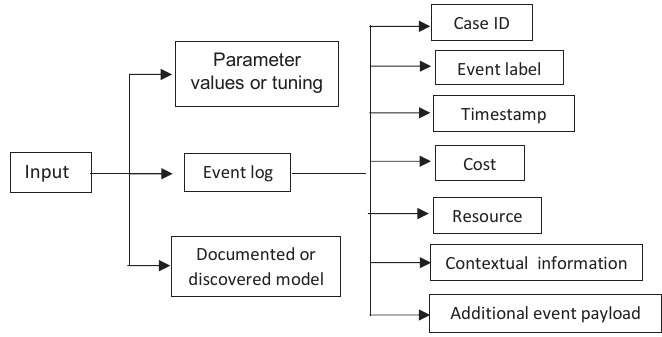
Figure 7. Input data used by most of the preprocessing